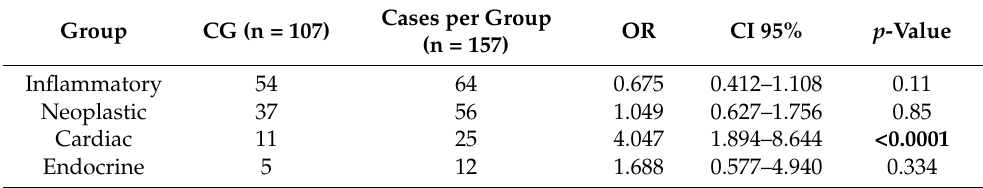
Table 1. ORs calculated for the groups with respect to